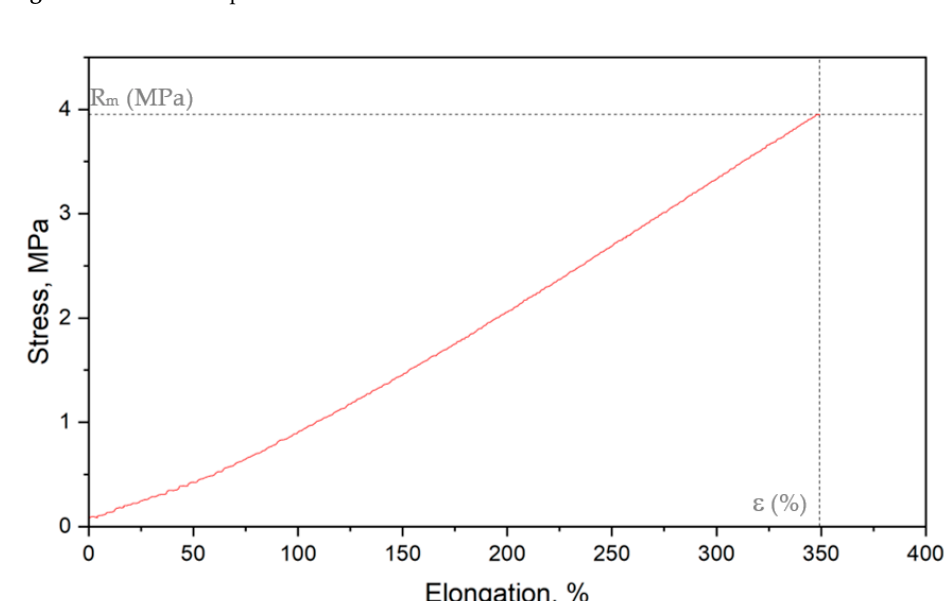
Figure 4. Stress–strain chart of the reference sample (Rm—stress at break, ε —elongation at break).